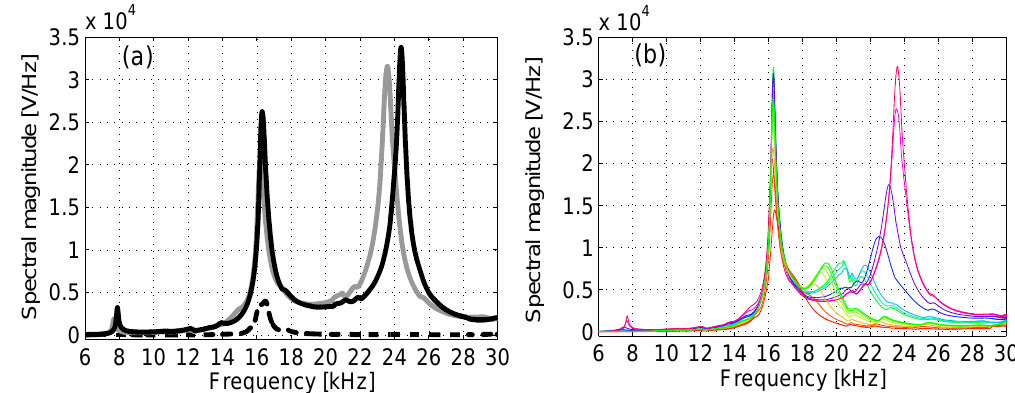
Figure 2. Evolution of the output signal spectra as a function of time. Data refer to Specimen No. 1. ( a ) Spectra at time “0” (intact state, solid black line), time “1” (damaged state, dashed black line) and time “n” (repaired state, solid gray line); ( b ) Spectra during the healing process, from time “2” to time